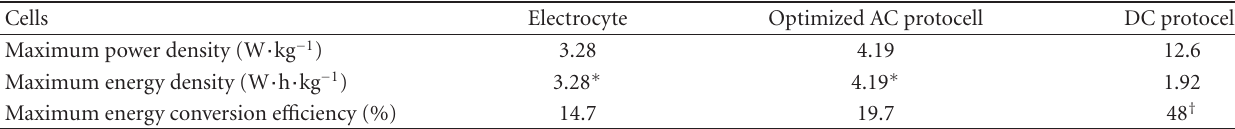
Table 1: The calculated electrogenic performance of three cell types: the natural electrocyte, and the optimized protocell with AC output, and the optimized protocell with DC output.